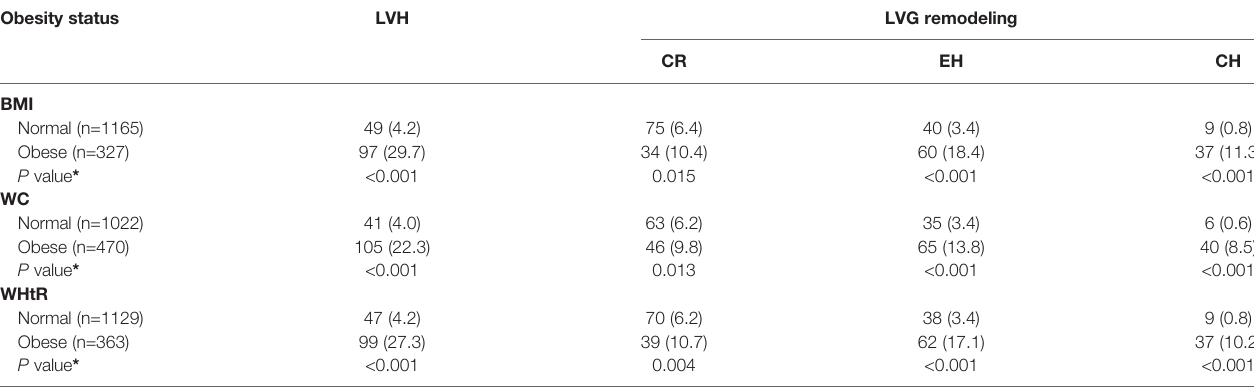
TABLE 2 | Prevalence of left ventricular hypertrophy and left ventricular geometric remodeling according to obesity status, n (%). Obesity status LVH